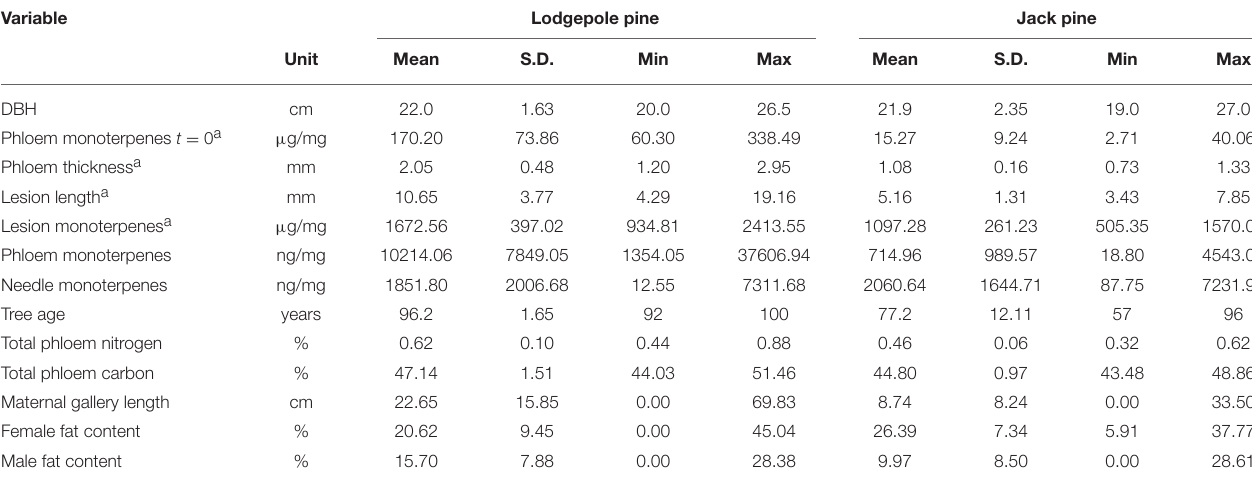
TABLE 2 | Mean measurements of variables measured in experimental trees and for beetles reared in experimental trees.